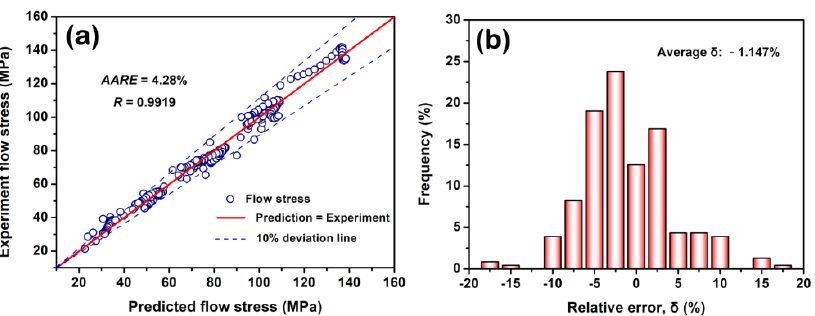
Figure 7. Comparison of experiment flow curves and predicted results of the strain-related Arrhenius constitutive model at different strain rates: ( a ) 0.01 s − 1 ; ( b ) 0.1 s − 1 ; ( c ) 1 s − 1 .